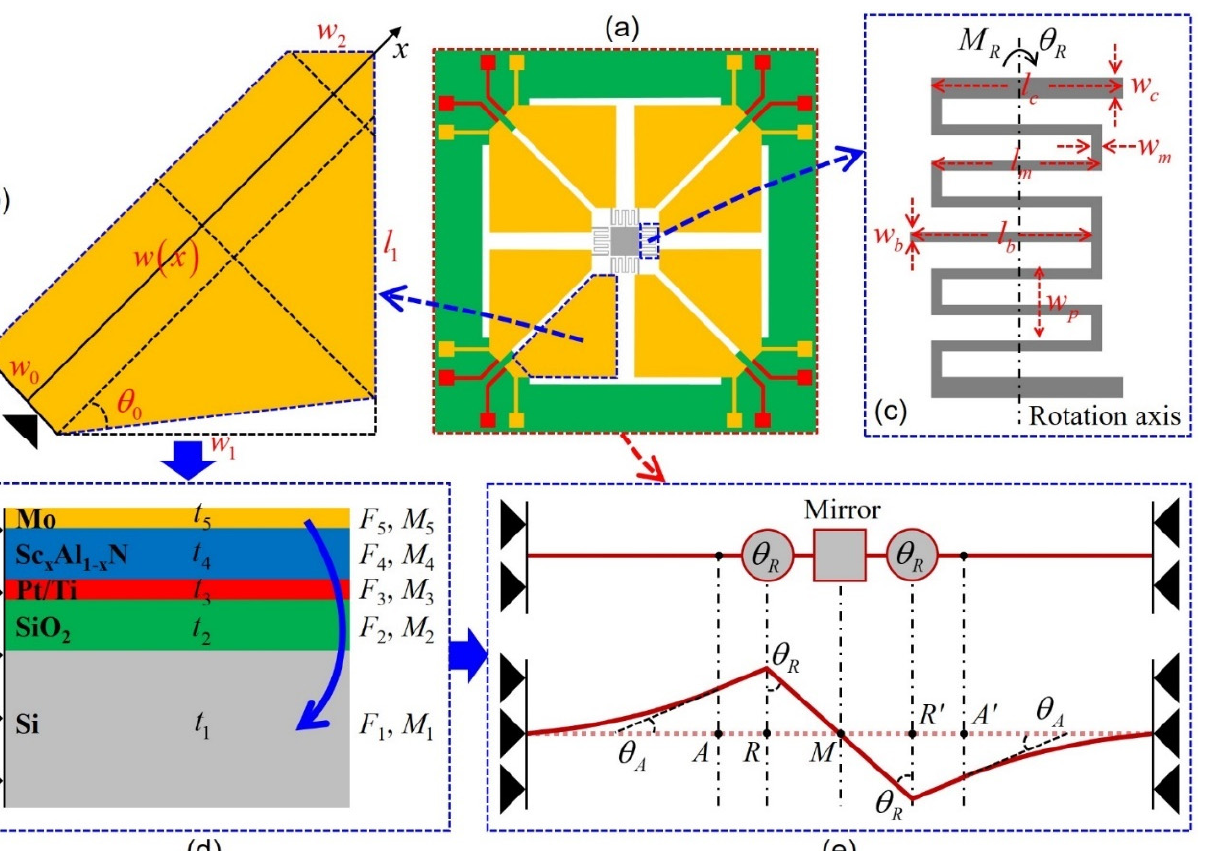
Figure 4. Meshing of the entire geometry of the proposed device. 3.1. Analytical Model of the Static Behavior Multilayer Trapezoidal Actuator The basic geometry of a multilayer trapezoidal actuator is illustrated in Figure 3. Such an actuator is comprised of one piezoelectric layer and four purely elastic layers, as a re- sult, the conventional model of only single-layer piezoelectric actuator is not valid here. According to the force and moment equilibrium conditions of the multilayer actua- tor, the total force